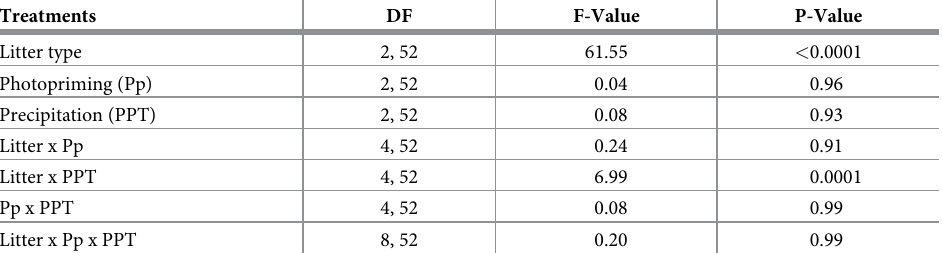
Table 2. Summary of ANOVA model results testing the effects of litter types, photopriming (Pp), precipitation manipulations (PPT), and their interactions on decay constants ( k values over the course of the experiment). Degrees of freedom (DF) are numerator and denominator respectively, F-Value is the computed test statistic, and P-Value is the asymptotic